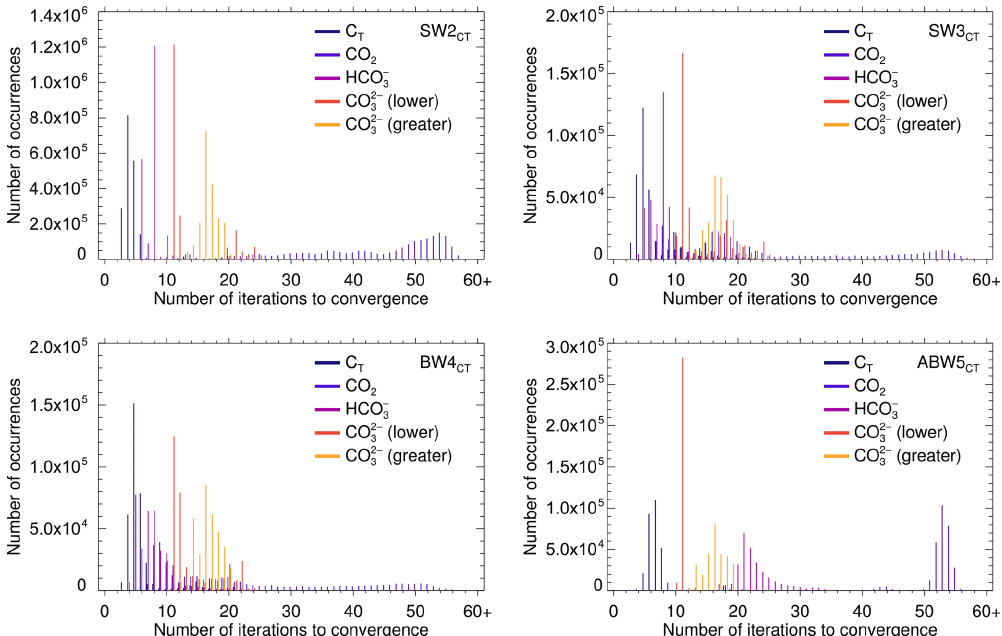
Figure 6. Number of iterations to convergence required by the various data pairs (separately for the lower and the greater [H + ] roots of the Alk T –CO 2 − problem), for each of the four test cases, carried out with solve_at_general (using a hybrid Newton–Raphson–regula 3 falsi–bisection method). The absolute maximum numbers of iterations were 58, 67, 64 and 56, for SW2, SW3, BW4 and ABW5, respectively, and 58 for SW1 (not shown).